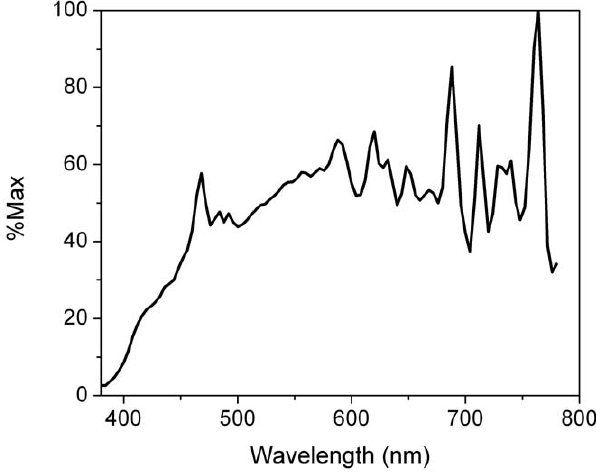
Figure 1. Spectral distribution of tungsten lamp as measured by a PR-650 SpectraScan Colorimeter (Photo Research, Chats- worth CA). Data were normalized to maximum power and plotted over the visible